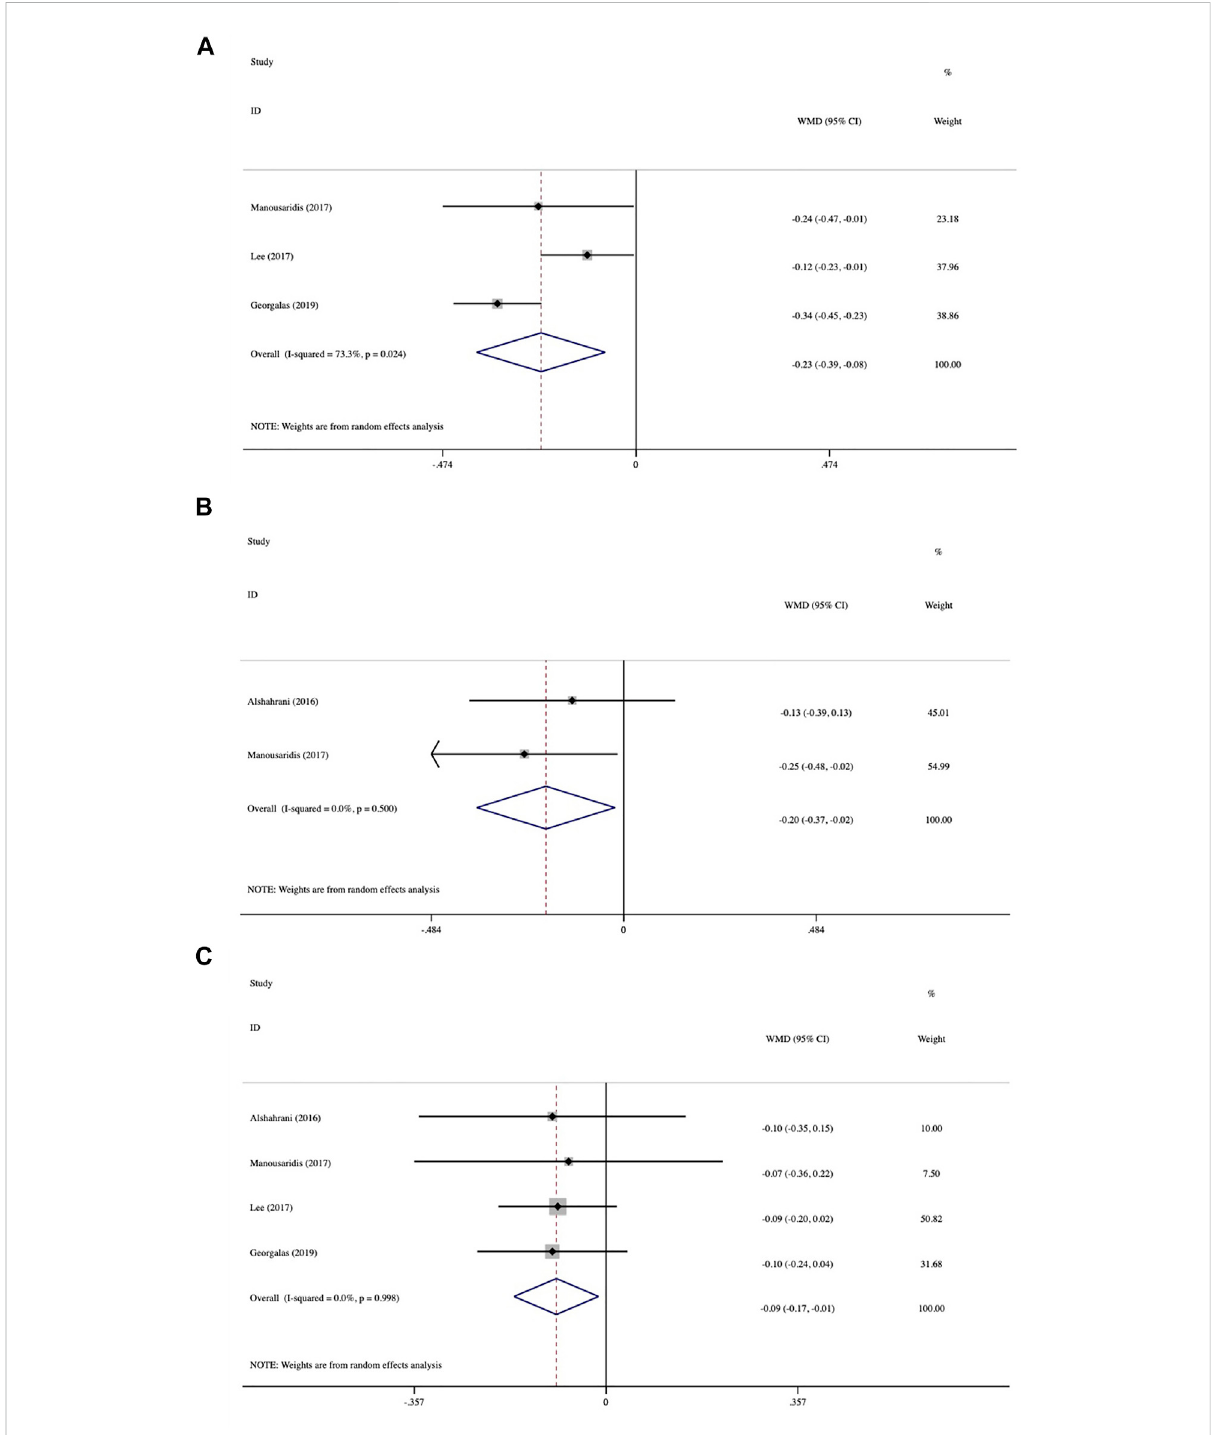
FIGURE 2 Forest plots of mean best-corrected visual acuity (BCVA) changes at various follow-up endpoints after switching therapy (A) at 2 months, (B) at 3 months, and (C) at 6